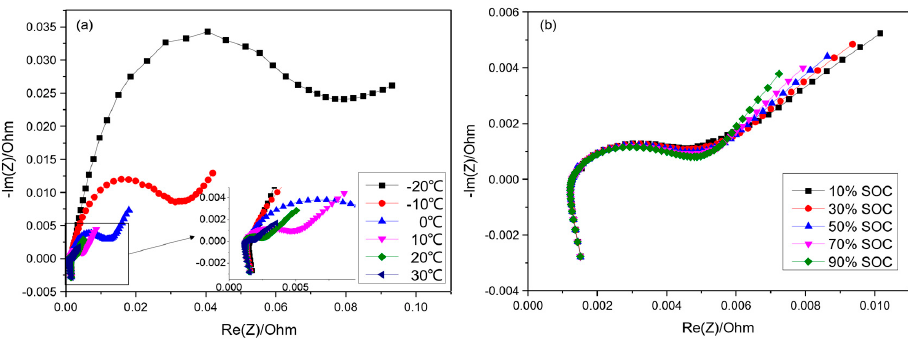
Figure 10. EIS of battery with uniform temperature: ( a ) 50% state of charge (SOC), different temperatures; ( b ) 10 °C, different SOCs.